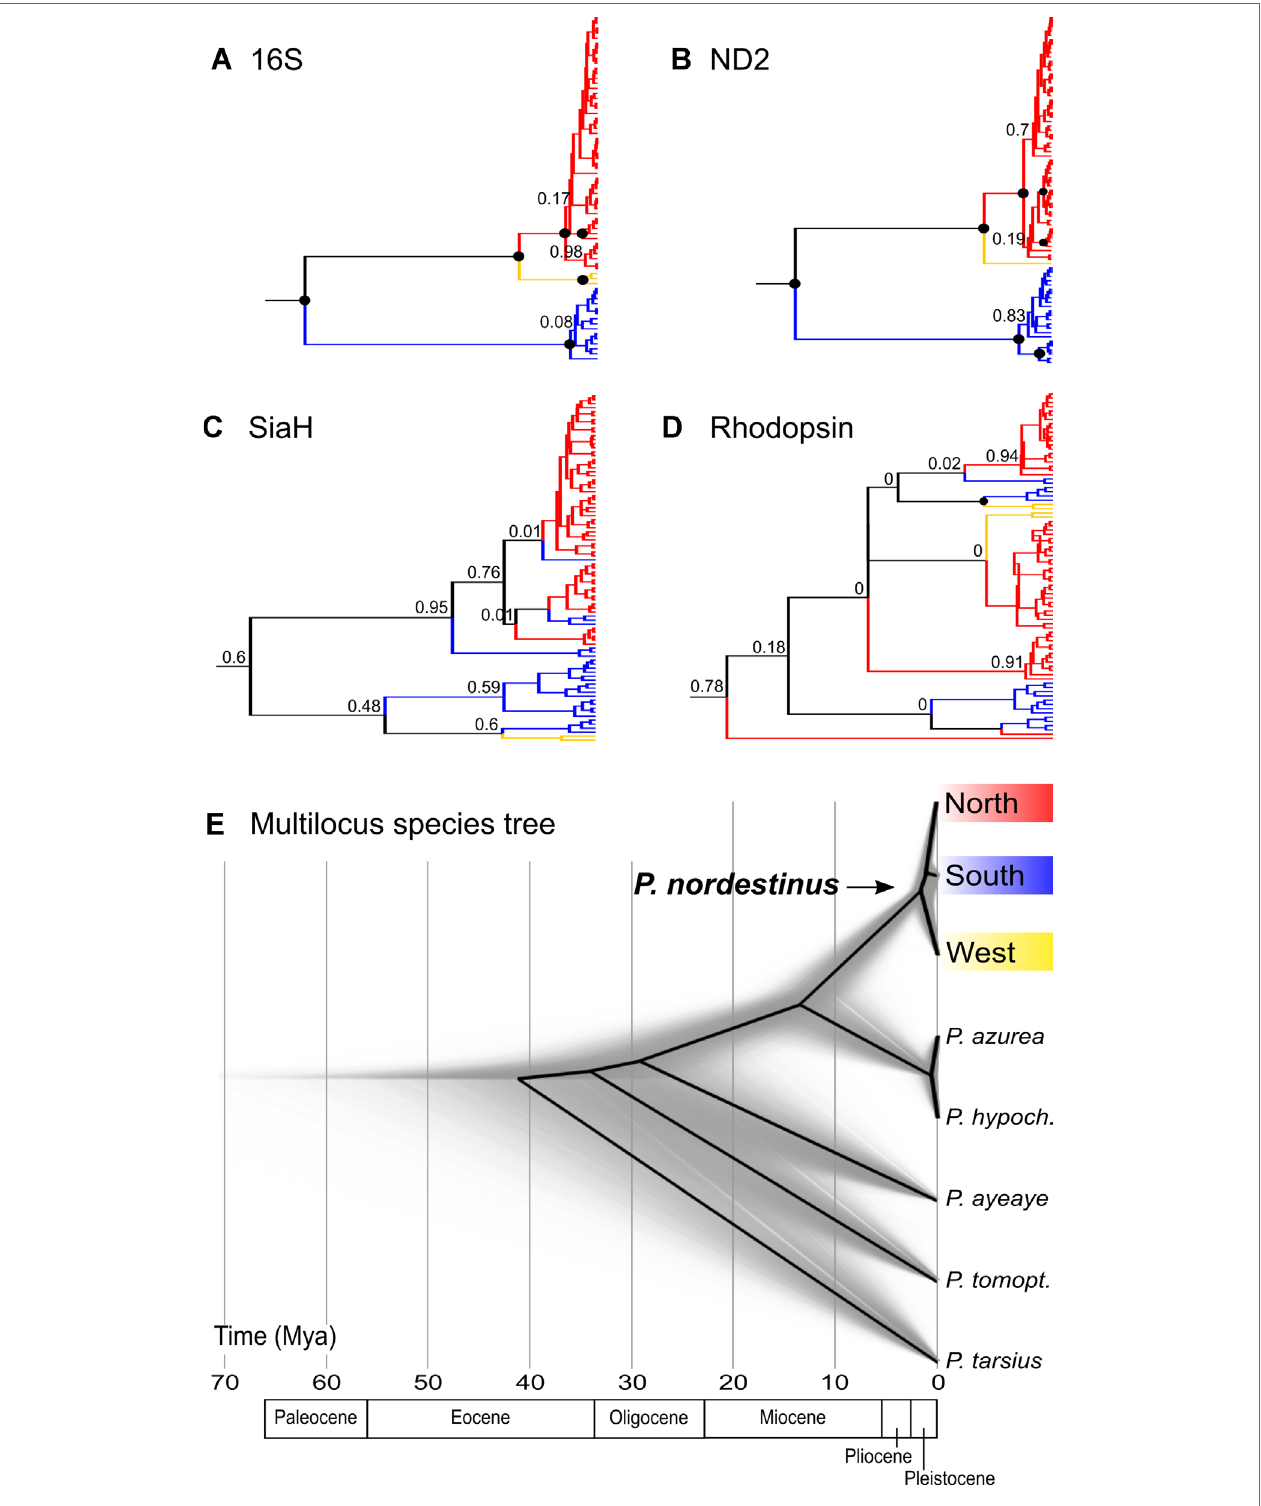
FIGURE 4 | Multilocus Bayesian inferences (*BEAST) results showing the gene trees obtained for each marker (A, B, C and D) and the multilocus calibrated species tree (E) . In the gene trees, colors represent the mitochondrial groups pointed by BAPS (red = Northern group, blue = South group, and yellow = West group), and the black circles in the nodes indicate posterior probability values =